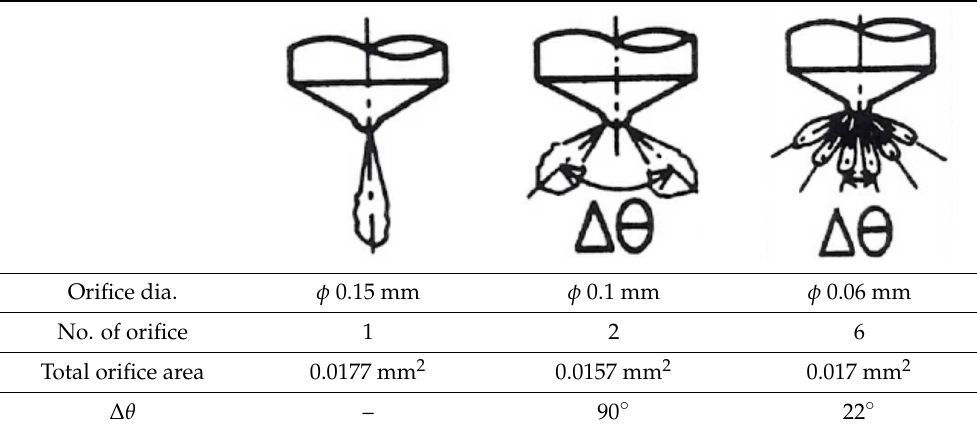
Table 6. Tested injectors [37].